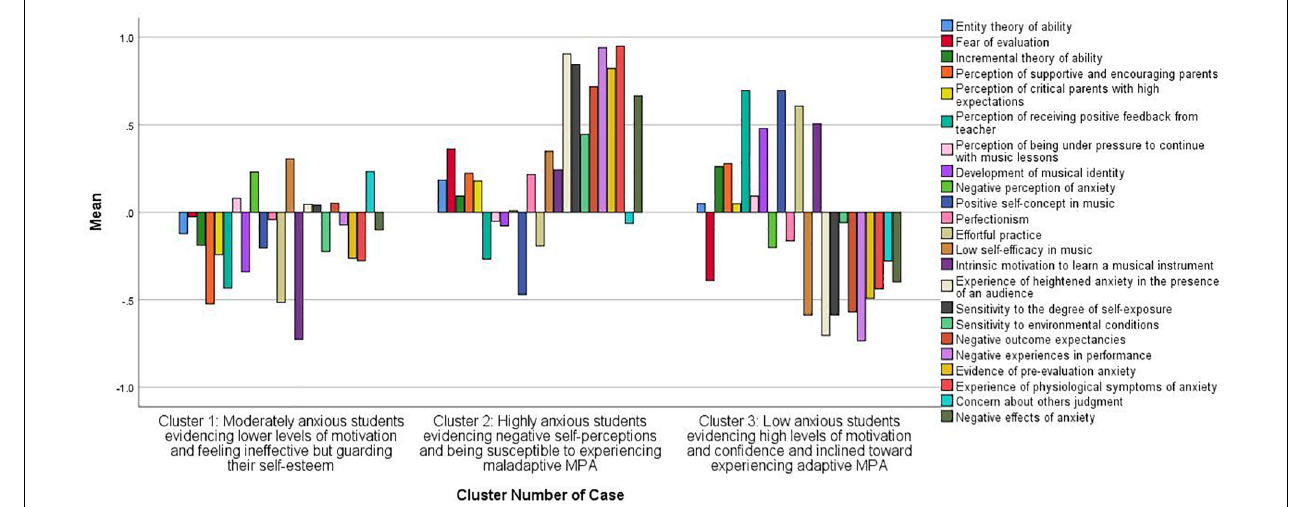
FIGURE 1 | The 3-cluster